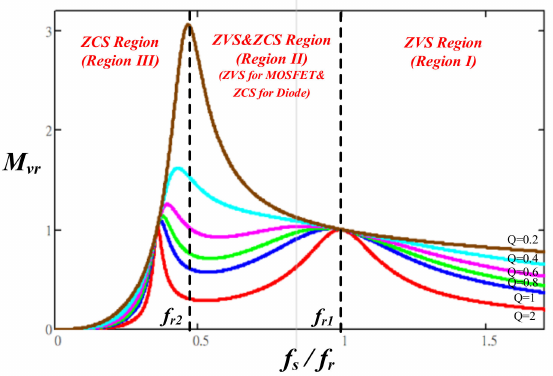
Figure 3. Voltage gain profile in the forward mode of the proposed bidirectional symmetric resonant